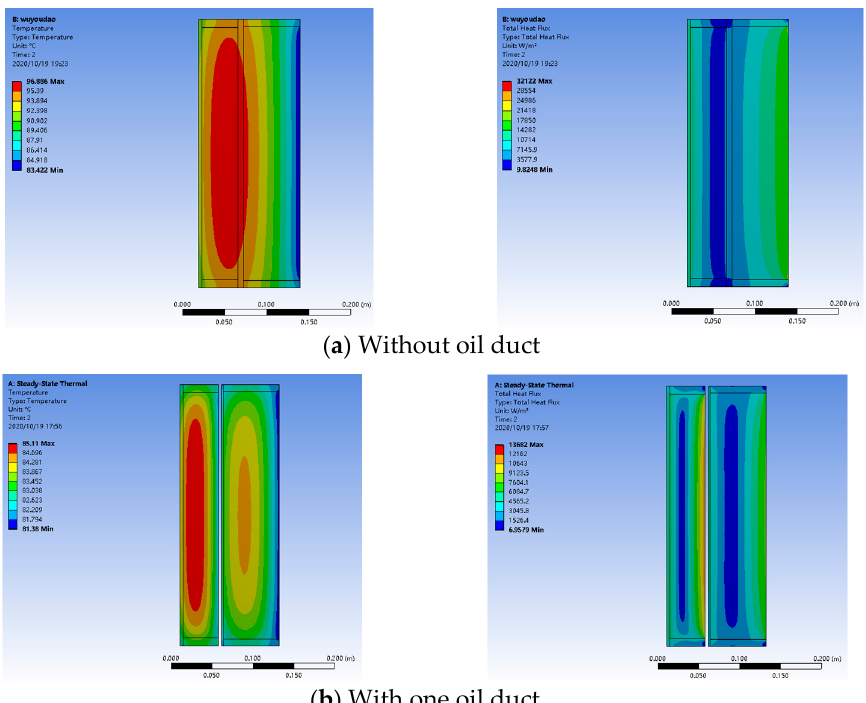
Figure 9. Filler design and actual filling effect.